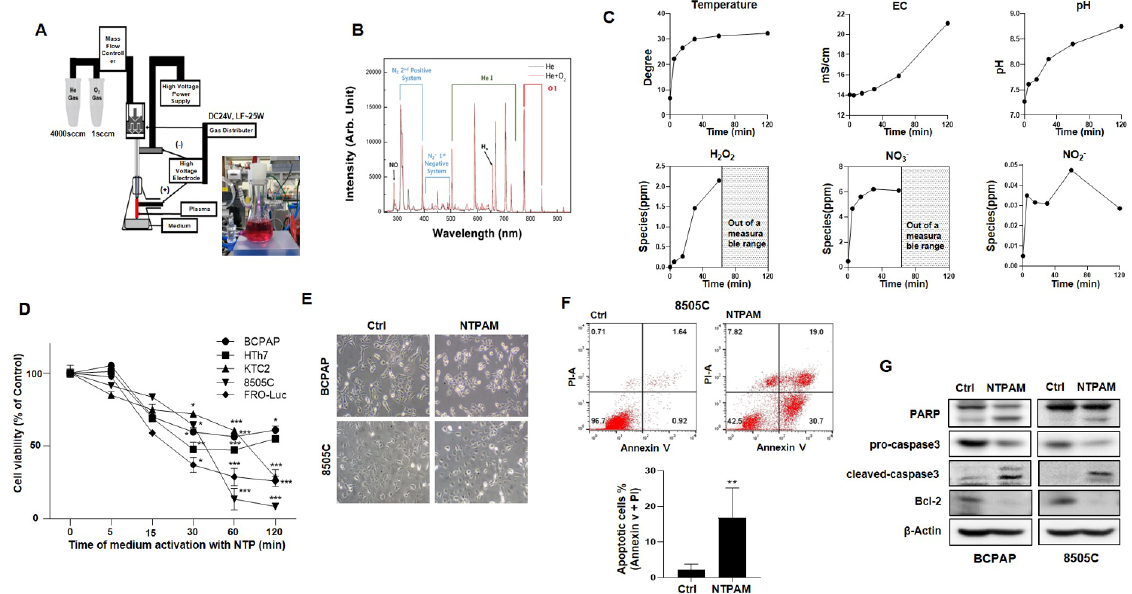
Figure 1. Apoptotic effects of nonthermal plasma-activated medium (NTPAM) on thyroid cancer (THCA) cells. ( A ) Diagram of the developed He- and O 2 -based NTP system and scheme as well as a photograph depicting the experimental design and preparation of NTPAM. ( B ) Measurement of the optical emission spectra (OES) of the NTP device with air gas flow. ( C ) Medium temperature, electrical conductivity (EC), pH, and concentrations of NO 3 − , NO 2 − , and H 2 O 2 following continuous NTP exposure. ( D ) Various THCA cells were treated with indicated concentration (0, 5, 15, 30, 60, 120 min of activation) of NTPAM for 24 h, and cell viability was analyzed using the WST1 assay. Results were analyzed using non-parametric one-way ANOVA followed by Dunnett’s post-hoc test. ( E ) Cell morphology changes in BCPAP and 8505C cells after 2 h dose-NTPAM treatment for 6 h. ( F ) Apoptosis was determined by AnnexinV/PI flow cytometry in 8505C cells after 2 h dose-NTPAM treatment for 24 h. Results were analyzed using Mann-Whitney U test. ( G ) Apoptotic proteins were examined using western blot analysis after 2 h dose-NTPAM treatment for 24 h. Each figure is representative of three independent experiments. Data were expressed as mean ± standard deviation of the mean ( ± SD). Differences were considered relevant at p < 0.05 (* p < 0.05, ** p < 0.01, *** p < 0.001).